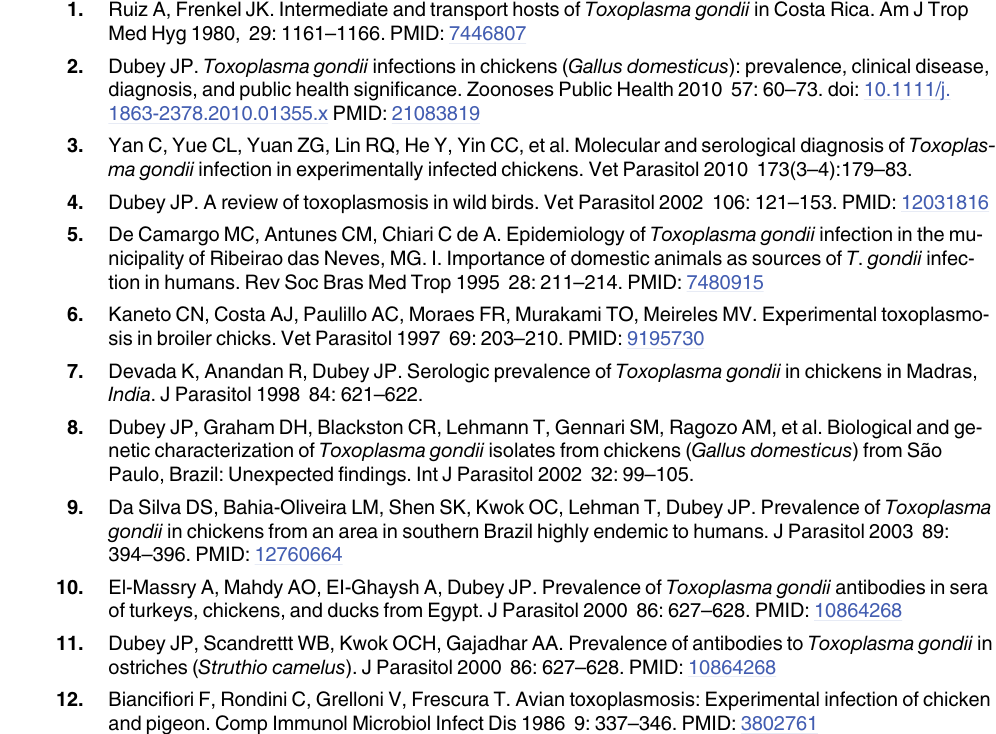
S1 Table. T . gondii strain RH tachyzoite proteins (S1 Fig.). Isoelectric point and molecular weight of shared immunogenic polypeptide spots using antibodies specific for IgG 56 dpi, IgG 7dpi, IgM 56 dpi and IgM 7dpi. S2 Table. T . gondii strain RH tachyzoite proteins (S2 Fig.). Isoelectric point and molecular weight of shared immunogenic polypeptide spots using antibodies specific for IgG 56 dpi and 7dpi. S3 Table. T . gondii strain RH tachyzoite proteins (S3 Fig.). Isoelectric point and molecular weight of shared polypeptide spots of 2-DE separated T . gondii strain RH tachyzoite proteins using antibodies specific for IgM 56 dpi and IgG 7